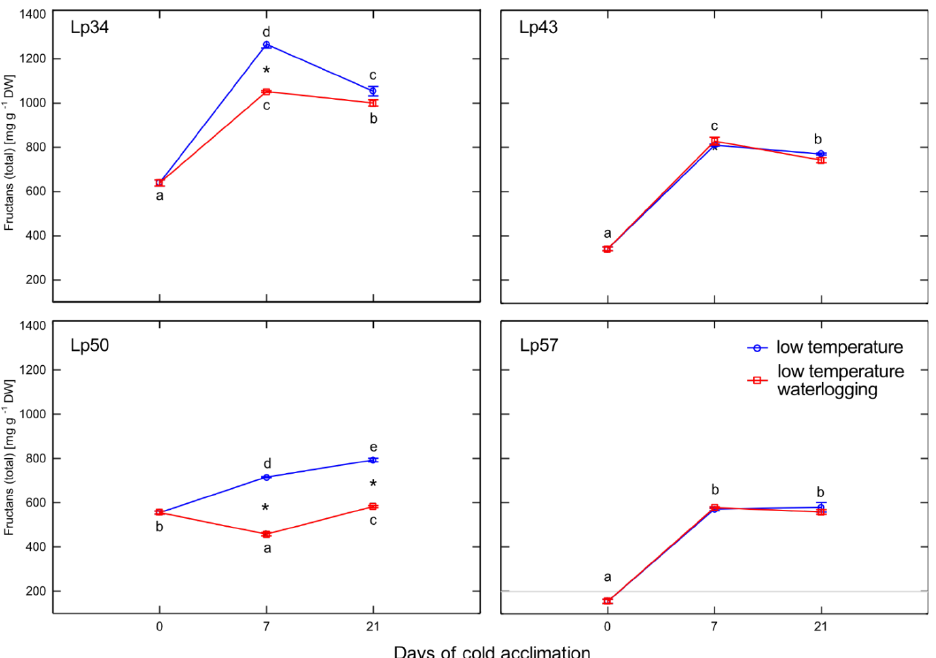
Figure 8. Total fructan content of cold-acclimated Lolium perenne genotypes. Four genotypes (Lp34, Lp43, Lp50, and Lp57) were tested. The results are means ( n = 4), error bars indicate the standard error. Asterisks indicate means that differ significantly between waterlogged and control plants according to one-way ANOVA ( p < 0.05). Different lower-case letters indicate means that are statistically different according to Duncan’s multiple range test ( p < 0.05). Int. J. Mol. Sci. 2021 , 22 , x FOR PEER REVIEW